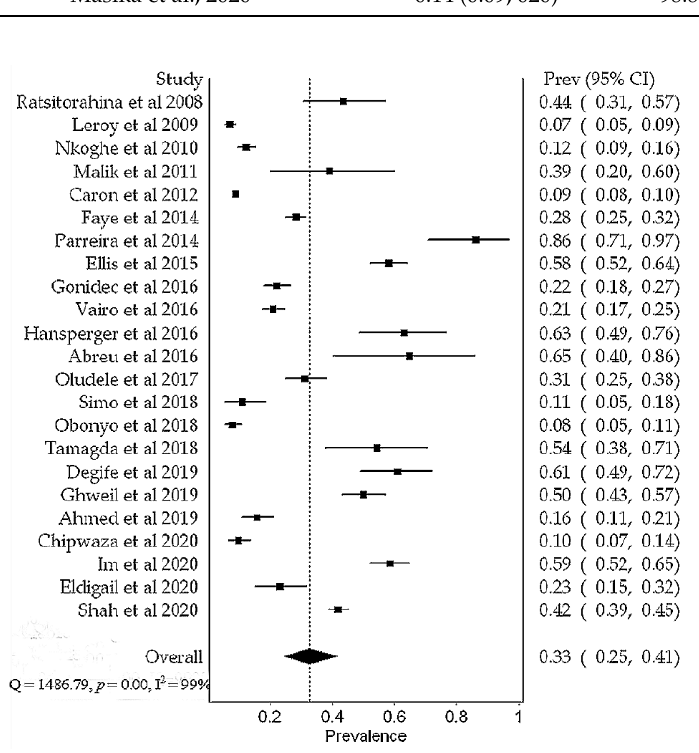
Figure 4. A meta-analysis of dengue virus prevalence in febrile patients during the outbreak peri- ods.